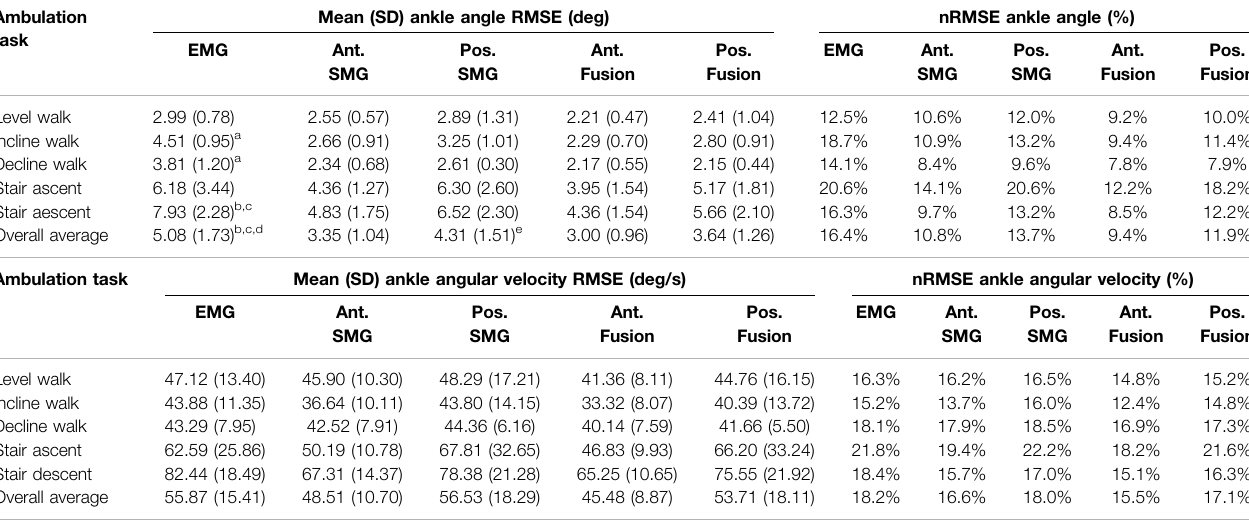
TABLE 4 | Mean (SD) root mean square error (RMSE) and range-normalized RMSE of ankle angle and angular velocity during level walking, incline walking, decline walking, stair ascent and stair descent. Joint kinematics were predicted by Gaussian process regression models trained and tested on features from fi ve sensing modalities: 1) surfaceelectromyography(EMG),2)anteriorsonomyography(Ant.SMG),3)posteriorsonomyography(Pos.SMG),4)sensorfusionofAnt.SMGwithEMG(Ant.Fusion),and 5) sensor fusion of Pos. SMG with EMG (Pos. Fusion). Overall average values are mean across all ambulation